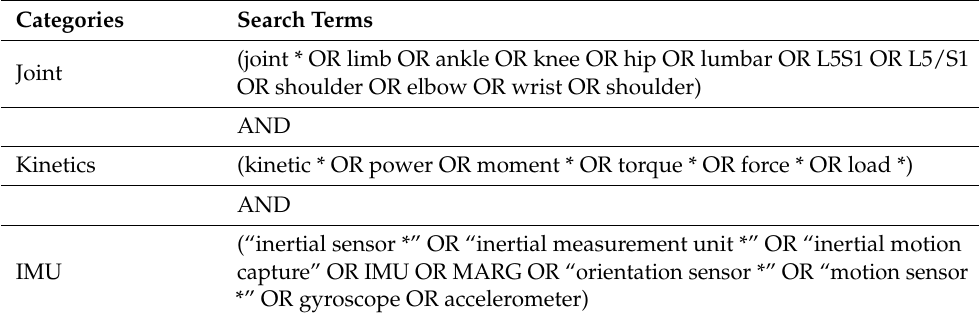
Table 1. Search terms applied for the literature